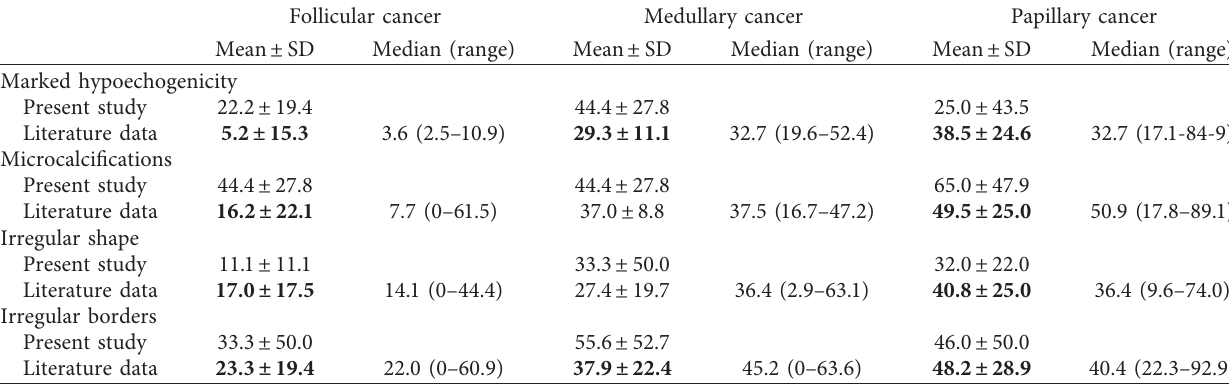
Table 4: The occurrence of individual suspicious ultrasound characteristics in three subtypes of thyroid cancer. For comparison, previously